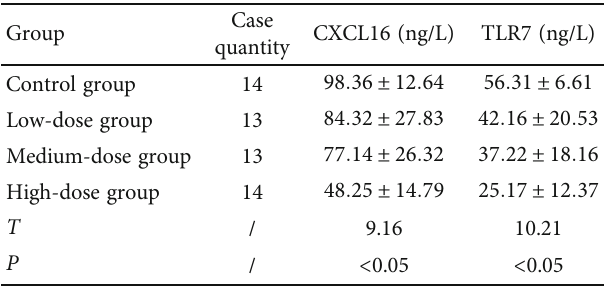
Table 3: The expression of CXCL16 and TLR7 in the four groups after